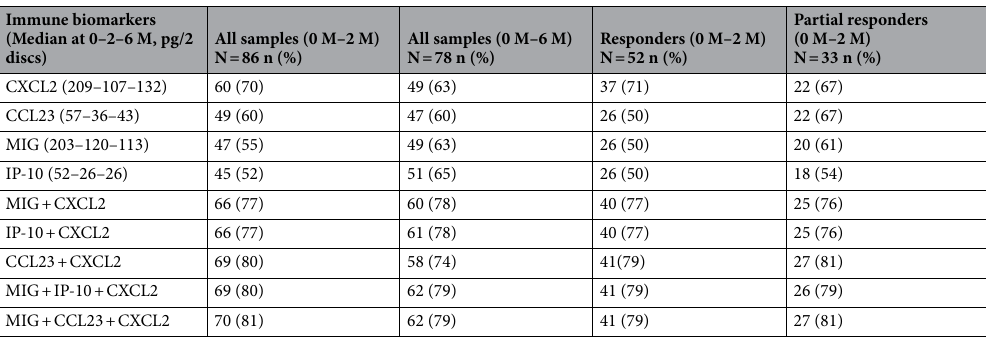
Table 3. Proportion of patients showing a significant change with treatment in the levels of four biomarkers individually and in combination constituting the biosignature, at 2nd and 6th month of treatment. N total number of patients, M month of treatment, n number of patients showing ≥ 20% change. Python And Data Analysis was used to compute the various possible combinations. A combination consisting of least number of biomarkers and covering the maximum number of patients was selected. To formulate a biosignature, those patient samples were chosen that showed ≥ 20% change from the baseline